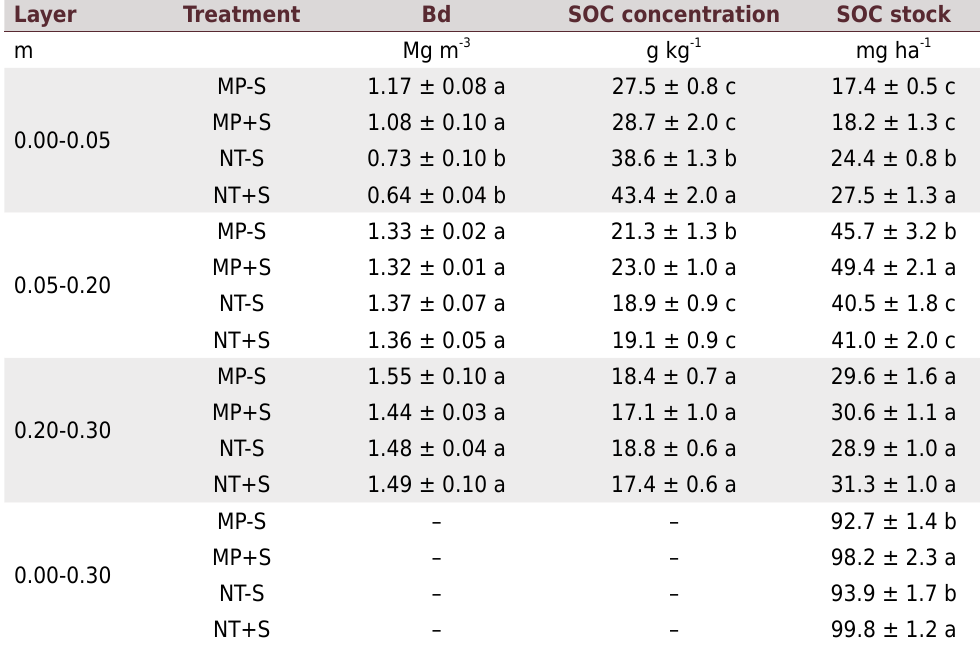
Table 2. Bulk density (Bd), soil organic carbon (SOC) concentration and stock (± standard deviation, n = 3) on an equivalent soil mass basis in the 0.00-0.05, 0.05-0.20 and 0.20-0.30 m layers, as affected by tillage